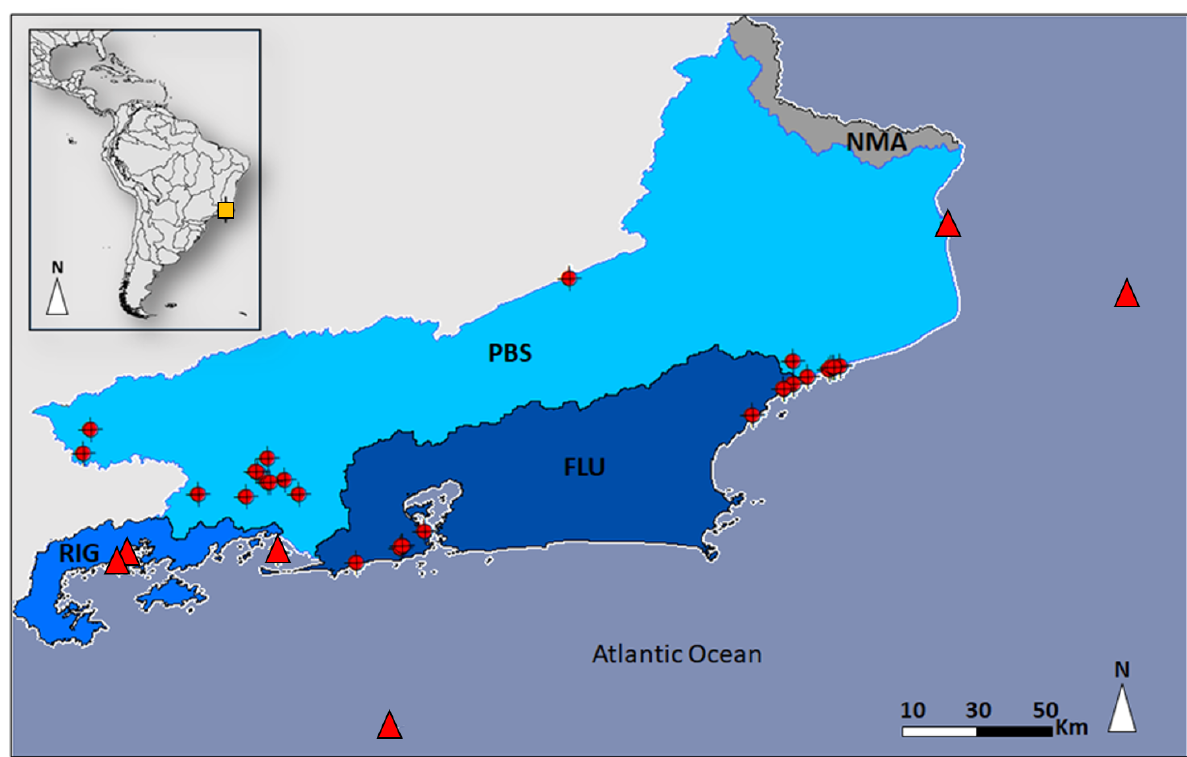
Figure 1. Map of the current known distribution of cladocerans in Rio de Janeiro State, Brazil. Background colors represent the four freshwater ecoregions in the state – RIG; Ribeira do Iguape, PBS; Paraiba do Sul, FLU; Fluminense and NMA for Northeastern Mata Atlantica. Distribution of non-marine taxa are described for PBS and FLU solely (red circles). Marine records are represented by red